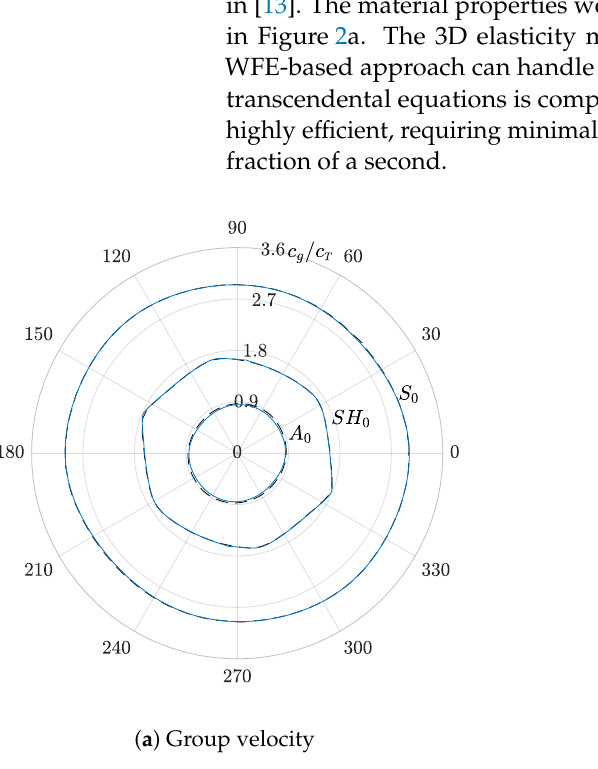
Figure 3. Wave velocity curves at 551 kHz for [+ 45/ − 45/0/90 ] s laminate obtained using the analytical (- -) and WFE (–)